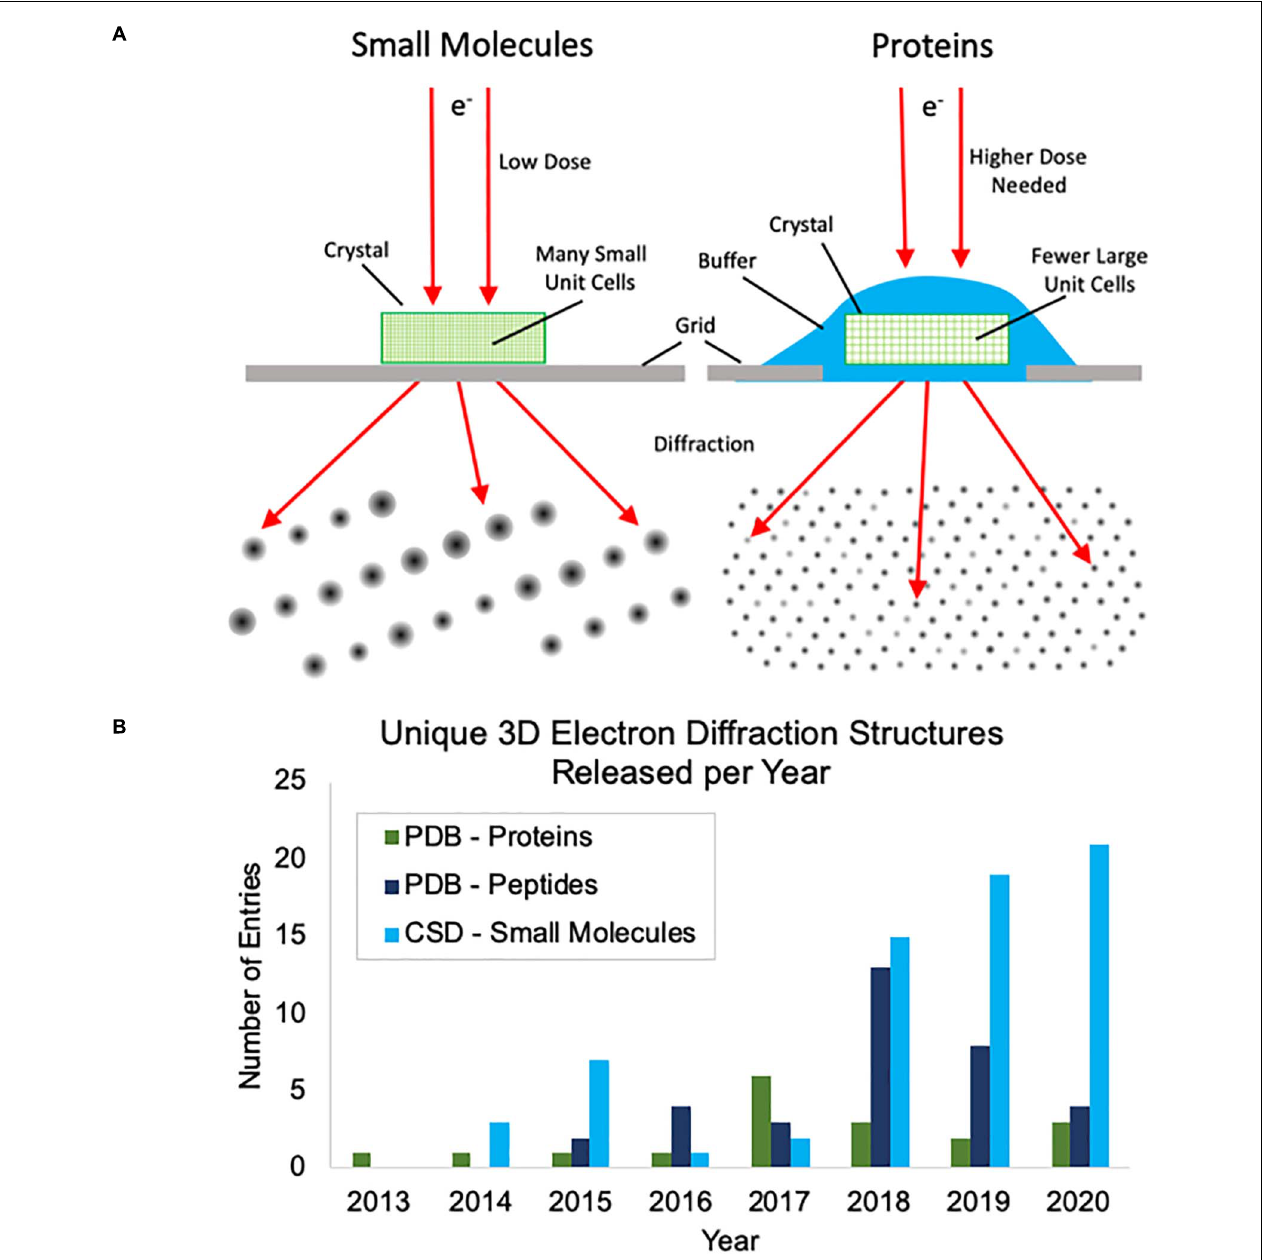
FIGURE 1 | (A) Cartoon depiction of the differences between small molecule and protein microcrystal electron diffraction (MicroED). First, protein crystals are grown in aqueous conditions and must be kept hydrated during grid preparation, whereas small molecule crystals are typically dry and can be directly applied to the grid without the need for sophisticated grid vitrification protocols. Second, small molecule crystals are composed of many small unit cells while protein crystals contain fewer, larger unit cells per crystal volume. Because of this, higher doses are typically needed for protein samples to generate diffraction spots of similar intensities. (B) The growth of unique structure depositions by year in the Protein Data Bank (PDB) and Cambridge Structural Database (CSD) determined by MicroED or related 3D electron diffraction techniques. Depositions into the PDB are broken up into proteins and peptides. Proteins were defined as having more than 50 amino